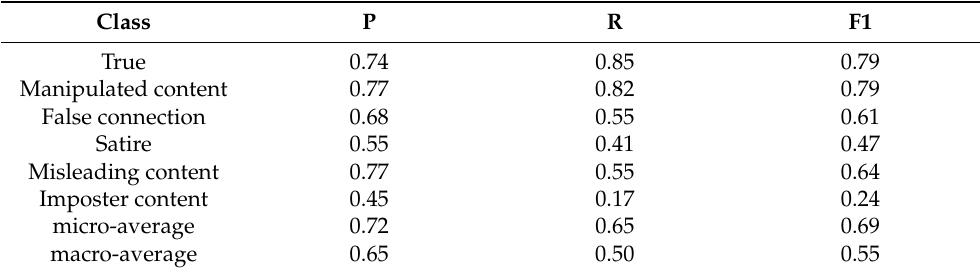
Table 7. Results of BiLSTM with static Glove vectors.